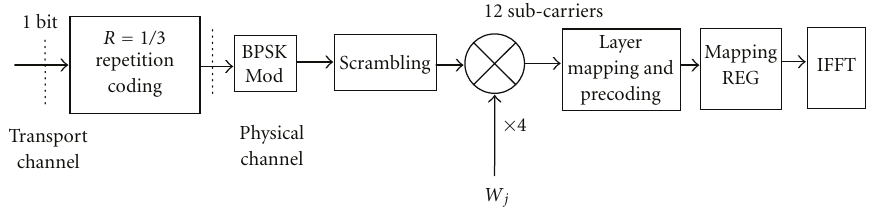
Figure 3: PHICH transmit